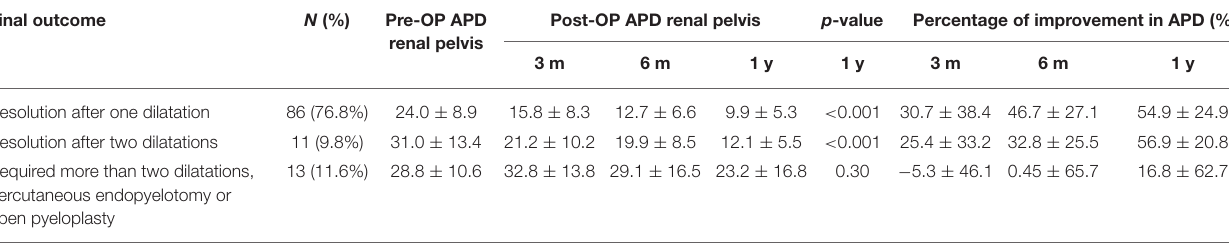
TABLE 4 | Follow-up ultrasounds: antero-posterior renal pelvis diameter.